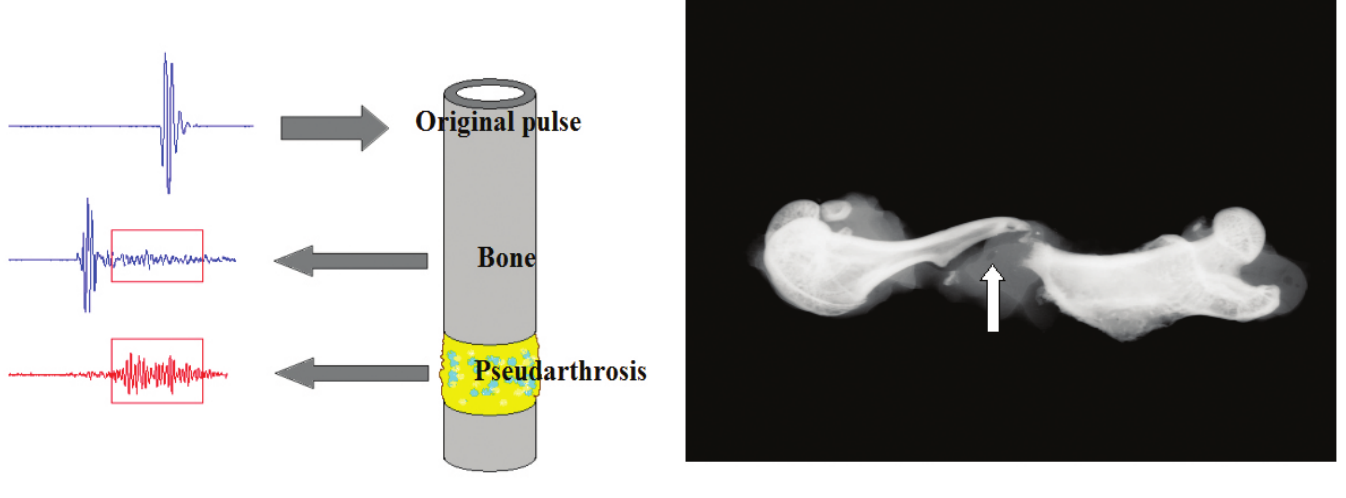
FIGURE 4 - Diagram illustrating the emitted pulse and the received echoes with backscatter signals (red square) of bone and pseudarthrosis